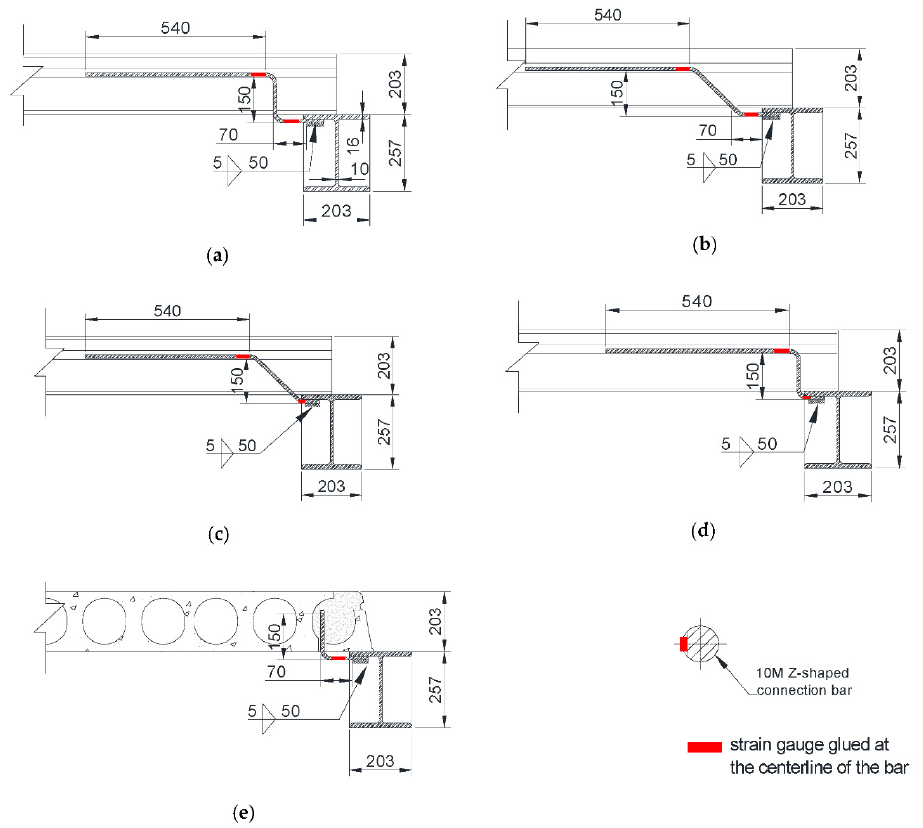
Figure 4. Steel bar connection detailing and locations of strain gauges (all dimensions in mm): ( a ) 90-degree bend bar—end-bearing connection; ( b ) 45-degree bend bar—end-bearing connection; ( c ) Reduced unrestrained bar length for 45-degree bend bar (EB-CN-45R); ( d ) Reduced unrestrained bar length for 90-degree bend bar (EB-CN-90R); and ( e ) 90-degree bend bar—side-bearing connections. (Dimensions in mm).